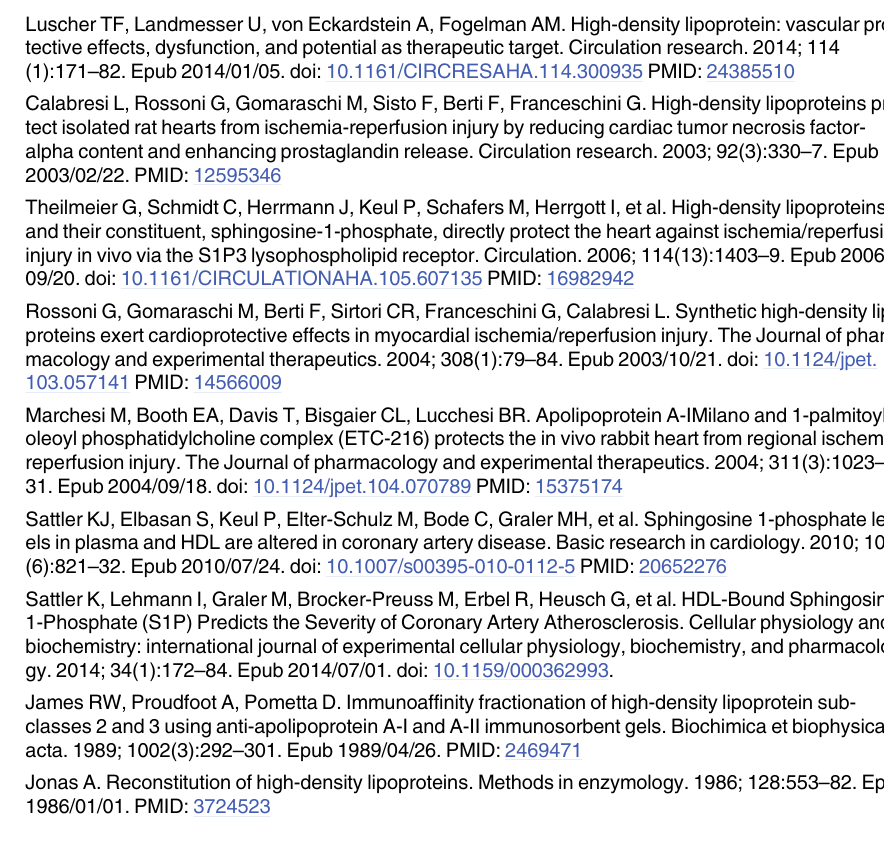
S6 Fig. Post-ischemic treatment with HDL does not decrease oxidation. Mice were submit- ted to LAD occlusion for 45min and hearts were reperfused for 24h. Mice were injected or not (control mice IR) with native HDL (nHDL), rHDLB (apoAI + POPC + S1P) one minute before reperfusion. 4-HNE (A) and DHE (B) content of frozen sections of infarcted hearts at 24 h of reperfusion. Data are mean±SEM (n = 7 – 9 per group). B. Representative images of 4-HNE (C) and DHE (D) stained middle heart sections of vehicle, native HDL or rHDLB-treated mice at 24 h of reperfusion. No significance difference between groups was found using unpaired-stu- dent